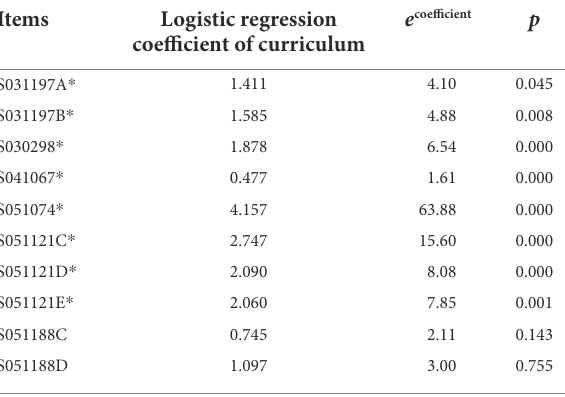
Table 5 Results of the instructional sensitivity for all items after controlling student ability.